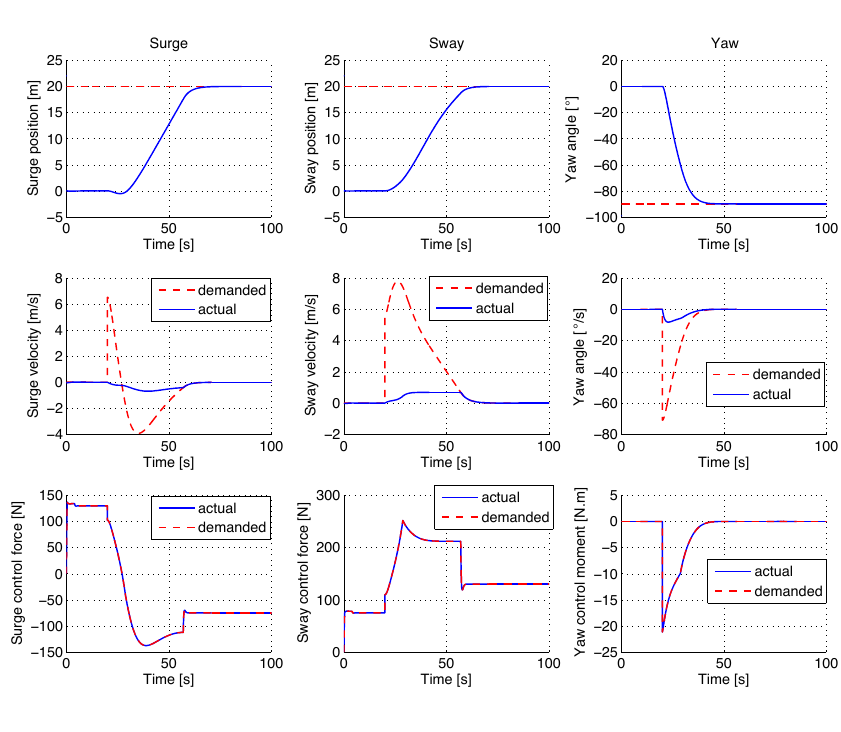
Figure 11: Performance of vehicle position regulation controller in current and position set point change under an actuator fault.